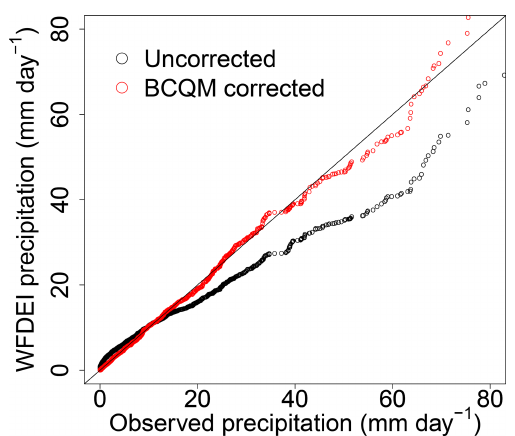
ficients when AOD observations are available ( N = 20462).